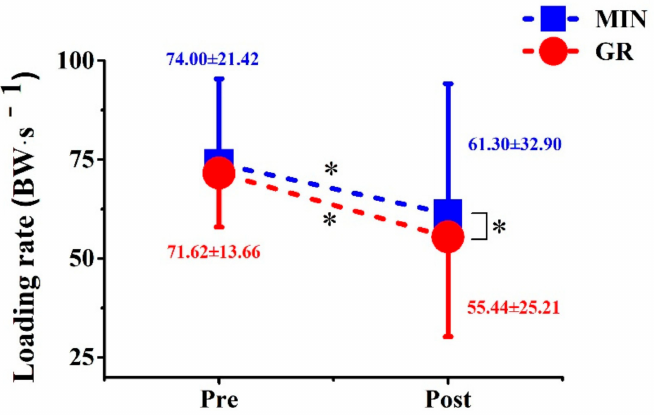
Figure 4. Comparison of loading rate between two groups before and after